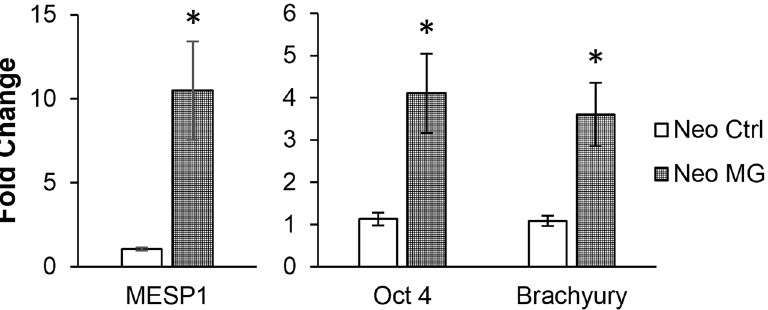
doi:10.1371/journal.pone.0132378.g003